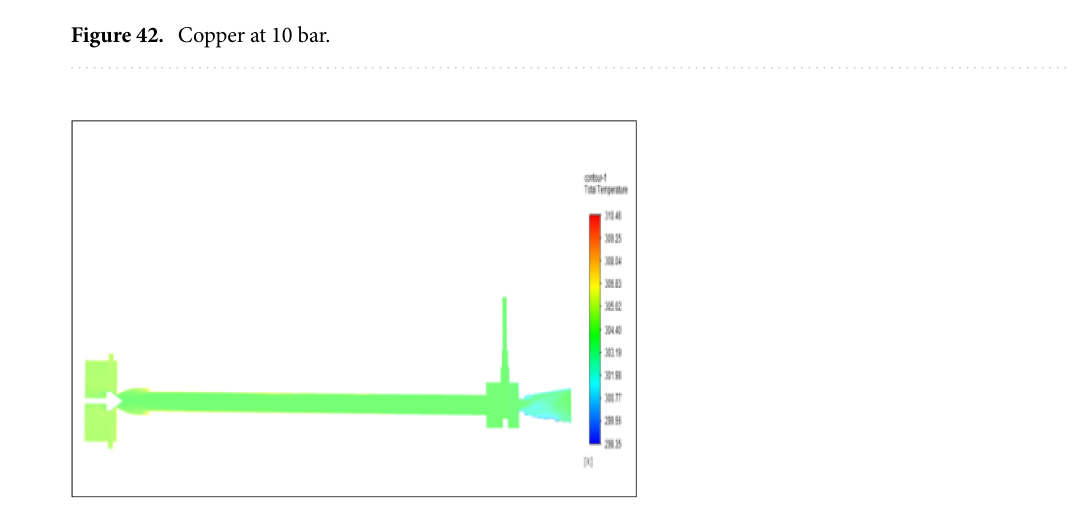
Figure 43. Stainless steel at 12